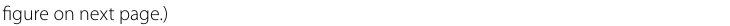
(See figure on next page.) Fig. 18 Lower teeth of Protadelomys lugdunensis Hartenberger, 1969, from Lissieu (Rhône), a L2628, right p4–m3; a1, occlusal view; a2, buccal aspect. b LIS 40, left dp4; b1, occlusal view; b2, buccal aspect; b3, lingual aspect. c : LIS 32, right p4; c1, buccal aspect; c2 occlusal view; c3, lingual aspect. d L2625, right p4–m3; d1, occlusal view; d2, lingual aspect. e L44, right p4–m2; e1, occlusal view; e2, buccal aspect; e3, lingual aspect. f LIS 37, right p4; f1, occlusal view; f2, buccal aspect; f3, lingual aspect. Scale bar 1 =